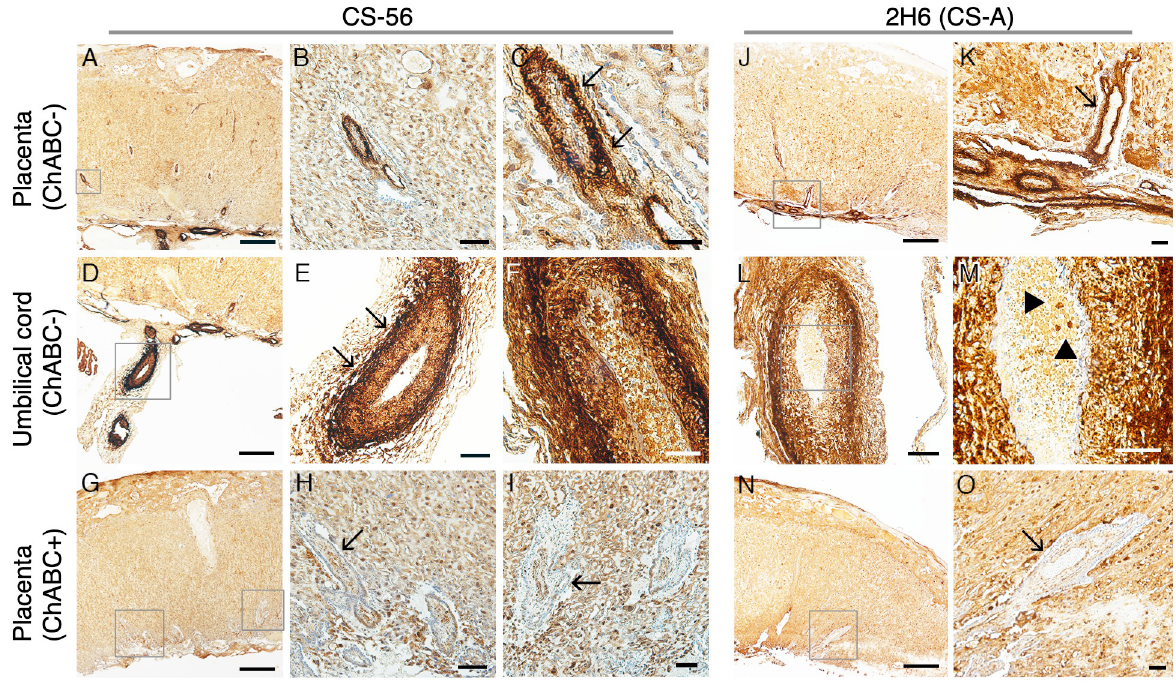
Fig 1. Immunohistochemical staining of chondroitin sulfate in rat placenta and umbilical cord. (A-I) Representative photomicrographs of the staining of anti-CS-56 antibody in rat placenta (A-C) and umbilical cord (D-F). Boxes A, D, and G are presented as the photographs B, E, and H/I, respectively. Fig 1C is a higher magnification image of Fig 1B. Immunoreactivity of CS was observed, especially in intima and media of vasculature (A-F, arrows in C and E), which disappeared by CS removal on treatment with Chase ABC (G-I, arrow in H and I). (J-O) Representative photomicrographs of the staining of anti-CS-A (2H6) antibody in rat placenta (J, K) and umbilical cord (L, M). Boxes in J, L, and N are presented as photographs of K, M, and O, respectively. Similarly, immunoreactivity was seen in intima and media of vasculature (J-M, arrow in K), and it disappeared by CS removal with Chase ABC (N, O, arrow in O). Bar, 500 μ m (A, D, G, J, N), 100 μ m (B, E, H, L), 50 μ m (C, F, I, K, M,